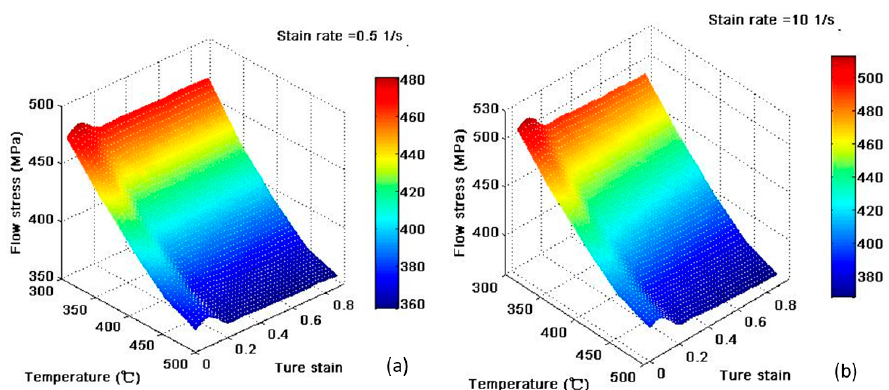
Figure 2. Flow stress curve of the 2A14 aluminum alloy. ( a ) The flow stress curve at strain rate of 0.5; ( b ) The flow stress curve at strain rate of 10.